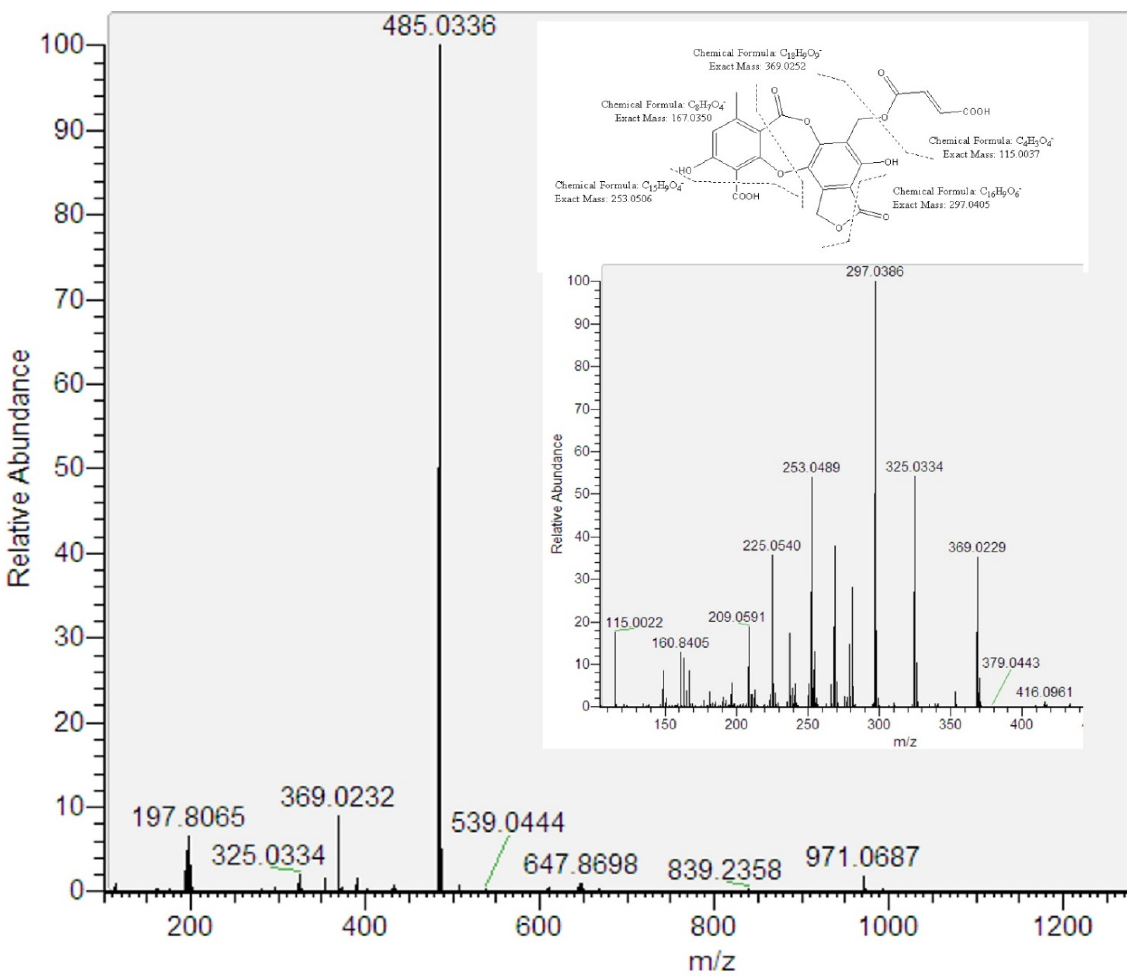
Figure 3. ESI/MS/MS spectra of [M–H] − of peak 7 and its proposed fragmentation